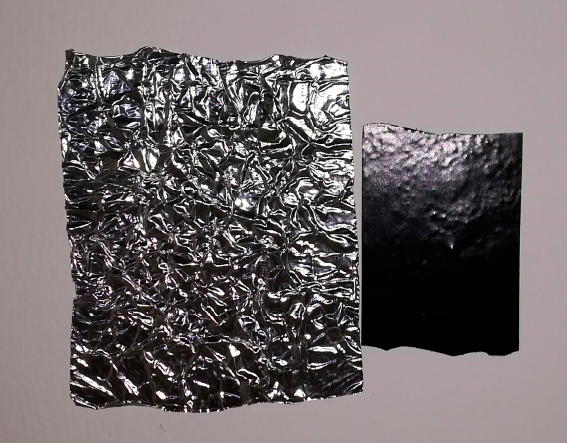
Figure 3. Crumpled foil used to determine reflective temperatures, fixed in situ under equilibrium with the affixed surface.